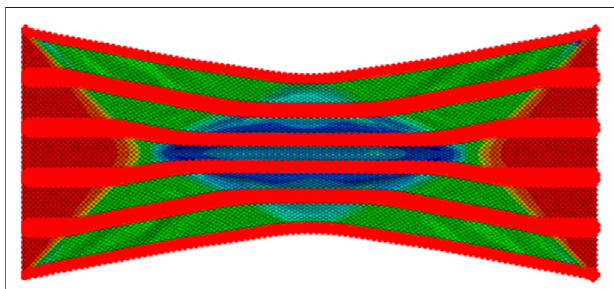
FIGURE 3 | Bias extension simulation with striped patches at 25%